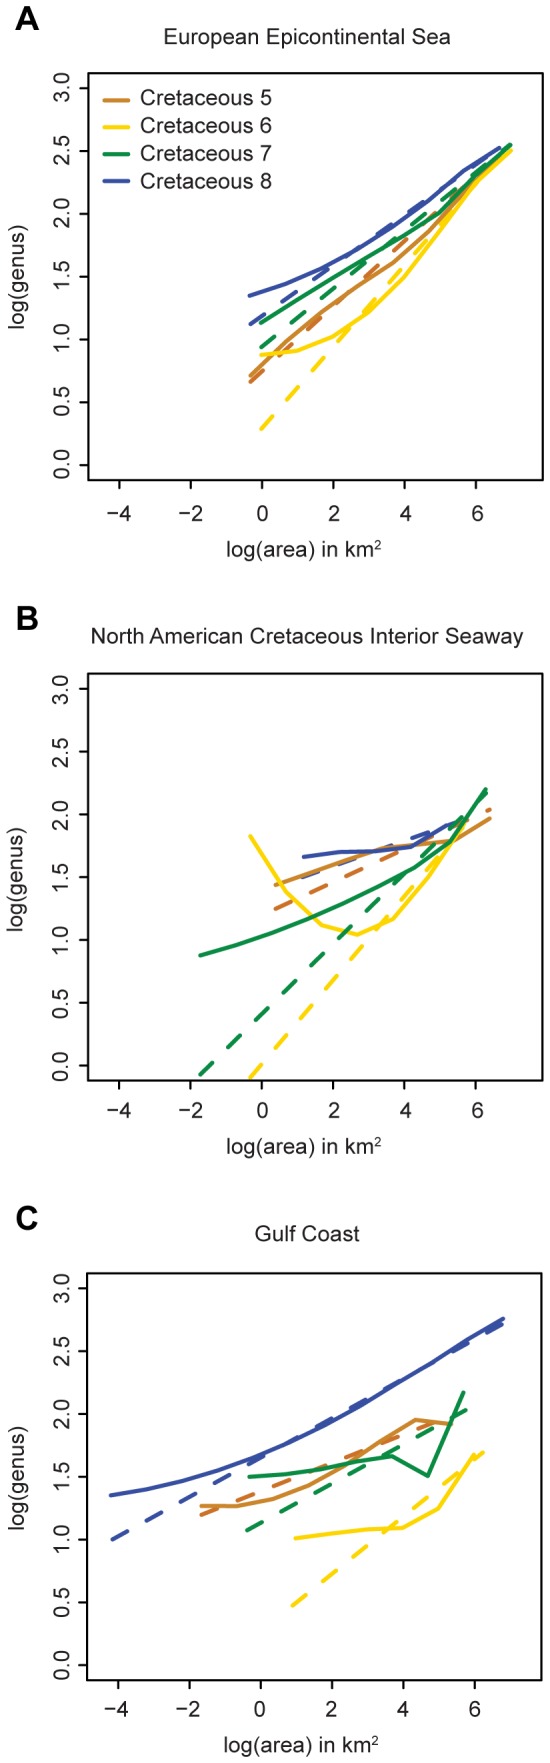
A comparison between least squares linear regression and LOESS regression.Least squares linear regression is displayed with dashed lines; LOESS by solid lines for (A) the European Epicontiental sea, (B) the North American Cretaceous interior seaway, and (C) the Gulf coast. LOESS was conducted with an alpha (smoothing parameter) of 0.4.